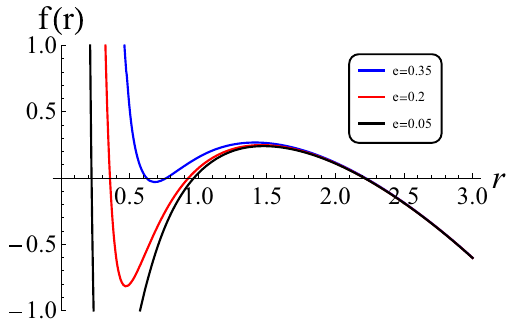
Fig. 2 The same as Fig. 1, but with different value of e (the other parameters are fixed at Λ = 1, k = 1, m = 1, and q = − 0 . 2)